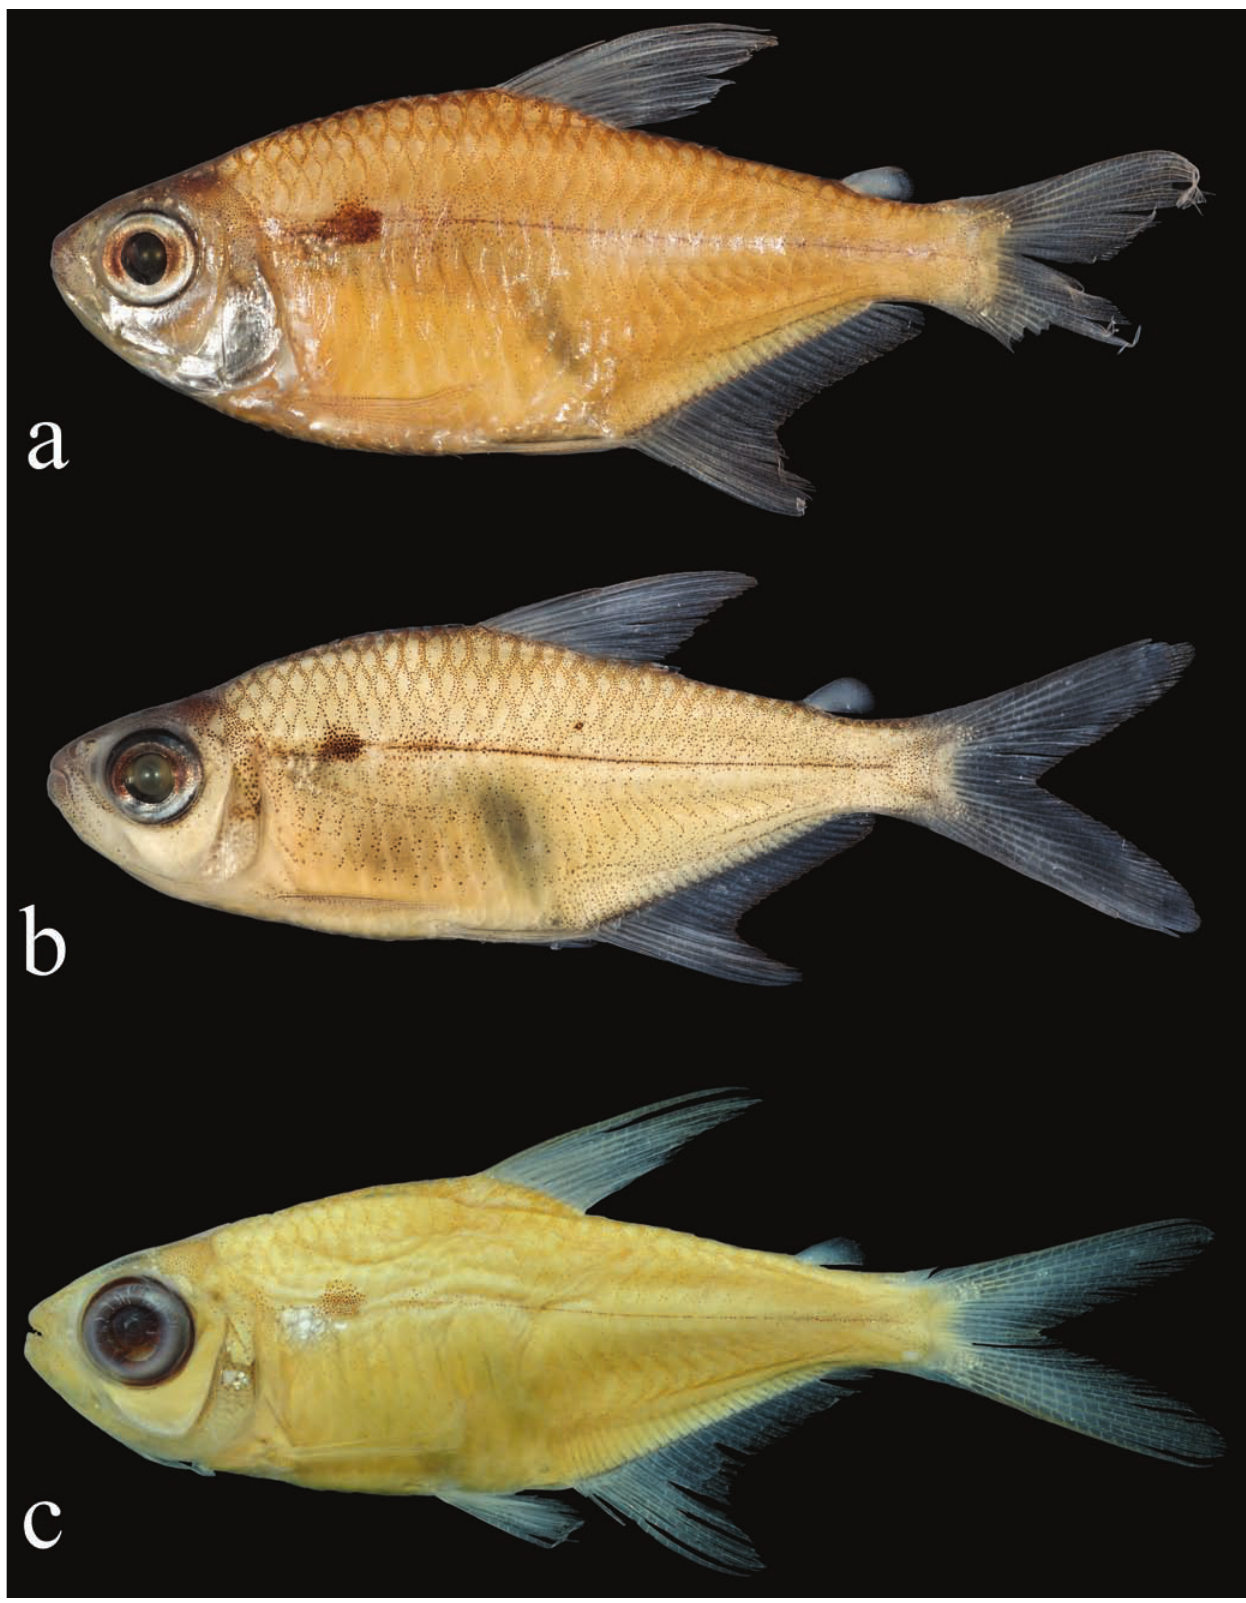
Fig. 7. Hemigrammus lunatus: both from Brazil, (a) MZUSP 102730, 33.1 mm SL, female, Amazonas State, Manaquiri, lago Janauacá system; (b) MZUSP 90475, 30.2 mm SL, male, Mato Grosso State, Cáceres, rio Sepotuba, rio Paraguai basin; Hyphessobrycon maxillaris (c) ANSP 53660, holotype, 28.3 mm SL, Brazil, Mato Grosso State, Descalvados, rio Paraguai